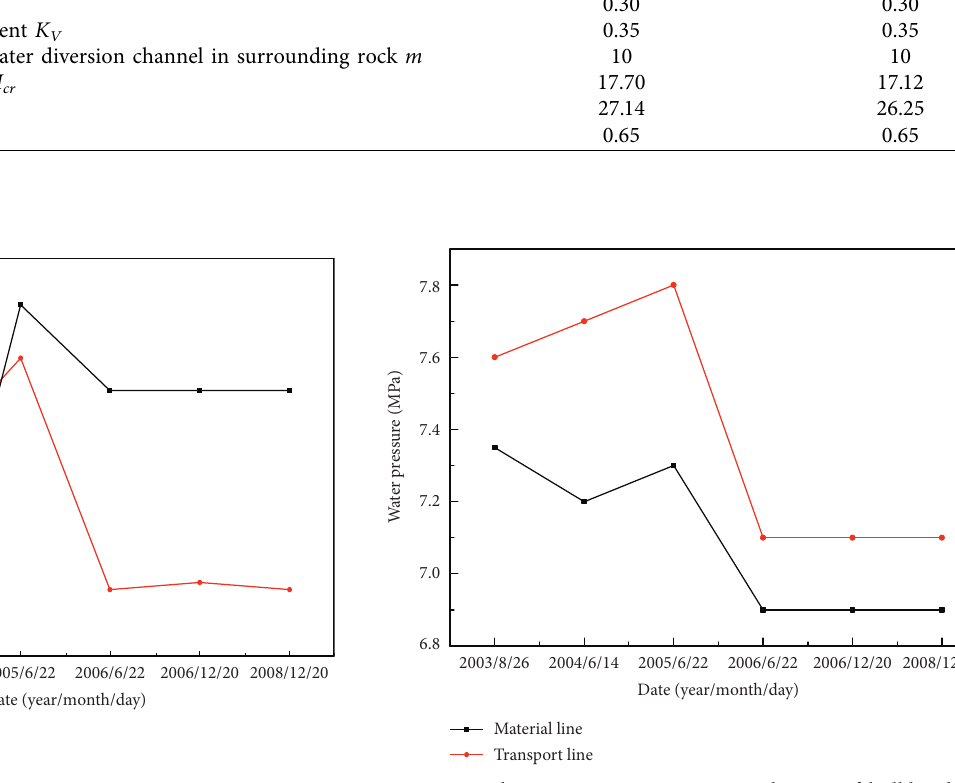
Figure 5: Changes in seepage flow with time of rock mass at Panel No. 21102.